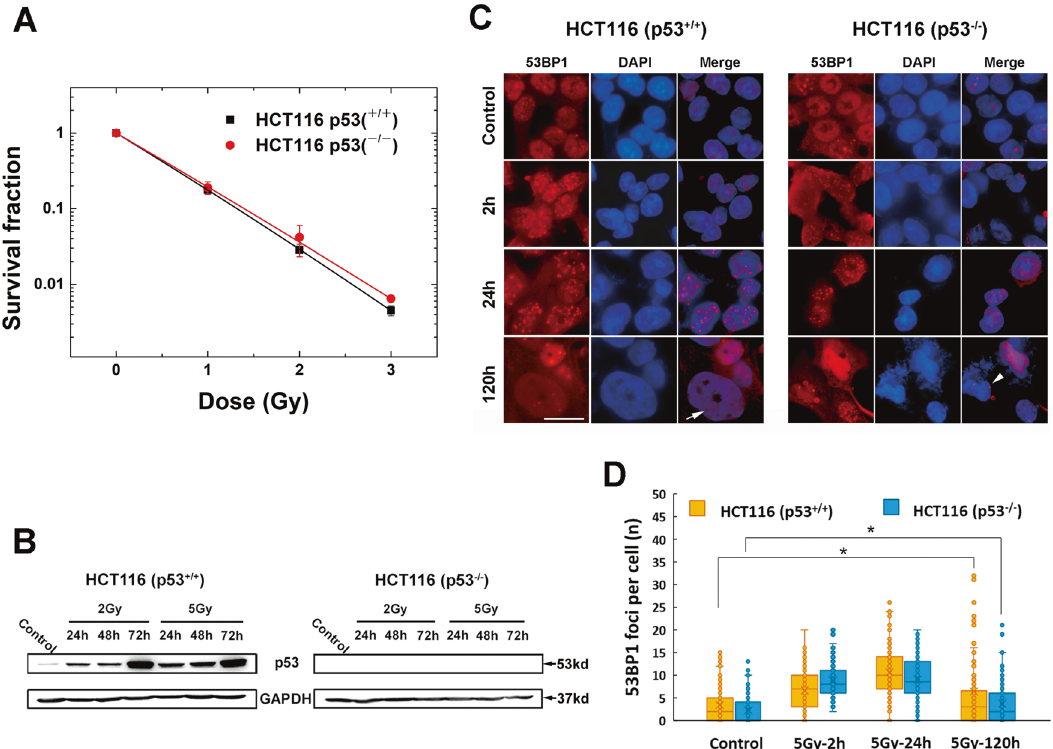
Fig. 1 Survival curves of p53 + / + and p53 − / − HCT116 cells after exposure to CIR (LET = 50 keV/µm) as well as representative images and statistics analysis showing recruitment and retention of 53BP1 induced by 5 Gy CIR. A Survival curves for p53 + / + and p53 − / − HCT116 cells following CIR. Data points represent the mean ± standard error (SE) of three independent experiments. B The veri fi cation of p53 expression by immunoblot after exposure to CIR. GAPDH level was used as a loading control. C Representative images of 53BP1 foci at various time points (2, 24, and 120 h) in p53 + / + and p53 − / − HCT116 cells. White arrow indicates 53BP1 foci in enlarged and fl attened cells; White arrowhead indicates 53BP1 foci observed in multilobulated nuclei. Scale bar: 20 µm. D Boxplots showing 53BP1 expression levels in both p53 + / + and p53 − / − HCT116 cells. A total of at least 50 cells were analysed at each time point from three independent experiments. Boxplots show median, upper and lower quartiles (boxes) and percentiles (whiskers). Data points represent the mean ± standard error (SE) of three independent